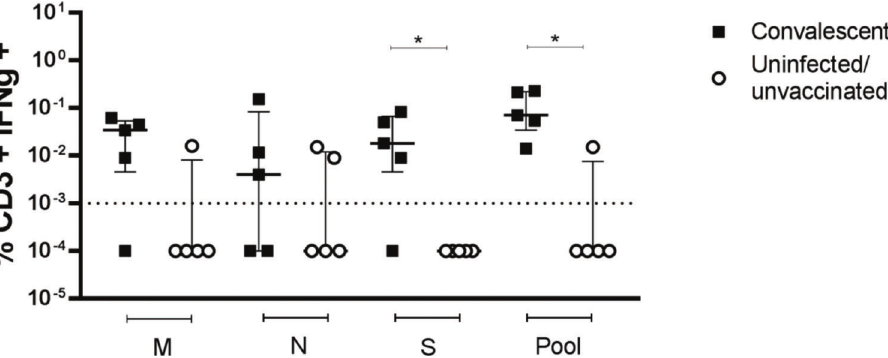
Figure 2 - T cell responses to SARS-CoV-2 peptide pools. PBMCs from convalescent COVID-19 individuals (black squares) (n=5) and from uninfected/unvaccinated donors (white circles) (n=5) were incubated for 18h with membrane (M) (1 m g/mL), nucleocapsid (N) (1 m g/mL) or spike (S) (1 m g/mL) peptides individually or a mixture of SARS-CoV-2 protein peptide pools grouped (Pool) at a final concentration of 1 m g/mL. The logarithmic scale represents the percentage of T cells producing IFN- g . Scatterplots show lines at the median with interquartile ranges. The dashed line represents the assay cut-off value of 0.001%. IFN- g expression by CD3 + T cells was analyzed by intracellular flow cytometry. T-tests and nonparametric Mann-Whitney tests were used to calculate p values. Asterisks denote statistically significant differences between the groups (* p o